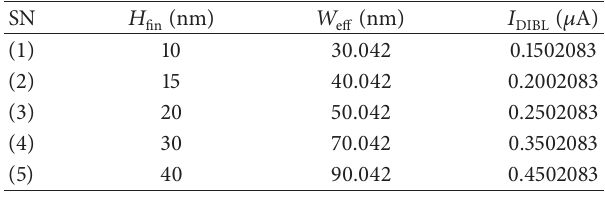
and 𝐼 with 𝐻 eff DIBL